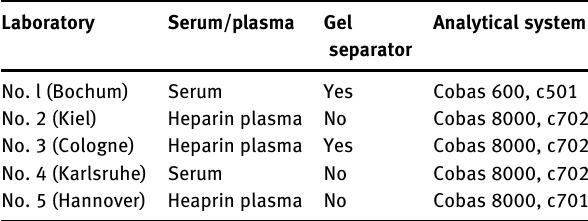
Table  : Analytical systems and sampling devices used by the various